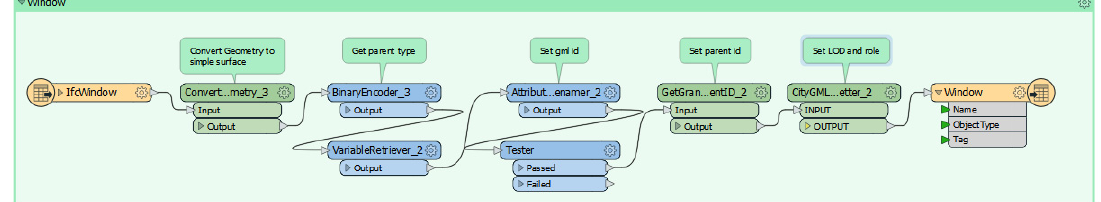
Figure 15. Example of workflow applied for windows, from “IfcWindow” to CityGML.